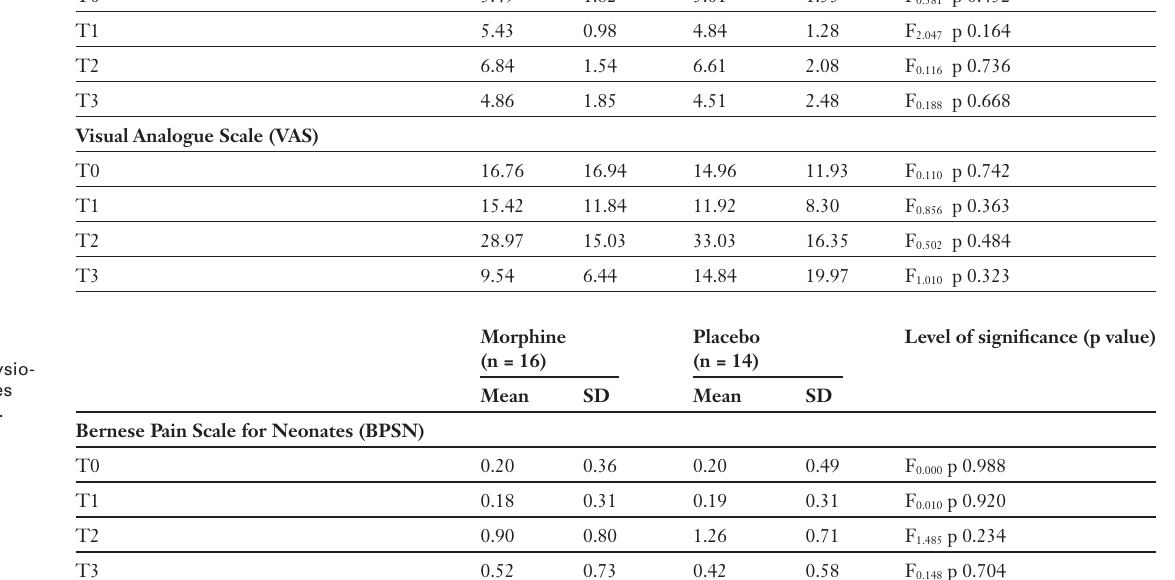
Table 3 Pain scores induced by endotracheal suctioning performed before any interven- tion (T0), after i.v. administration of study medication (T1), during endotra- cheal suctioning (T2) and after comforting technique (T3).